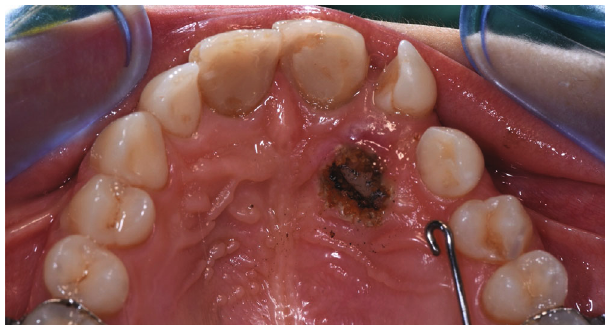
Figure 4: Surgical incision after laser surgery.